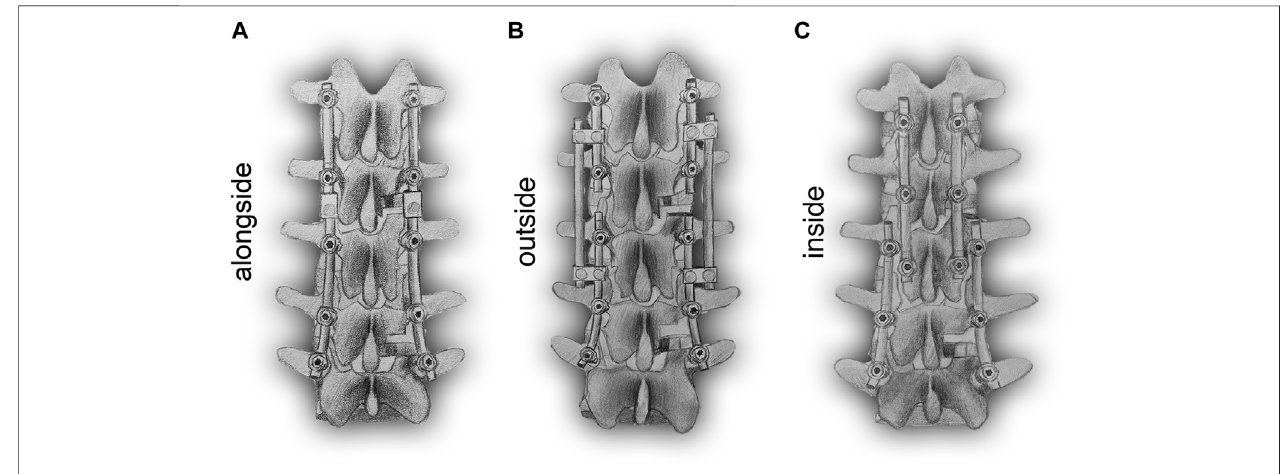
FIGURE1| Schematicposterior-anteriorillustrationofrevisionmodelswithrevisionrodsplacedalongside (DRCm,A) ,outside (SRC,B) ,andinside (CBTC,C) the previous rods.